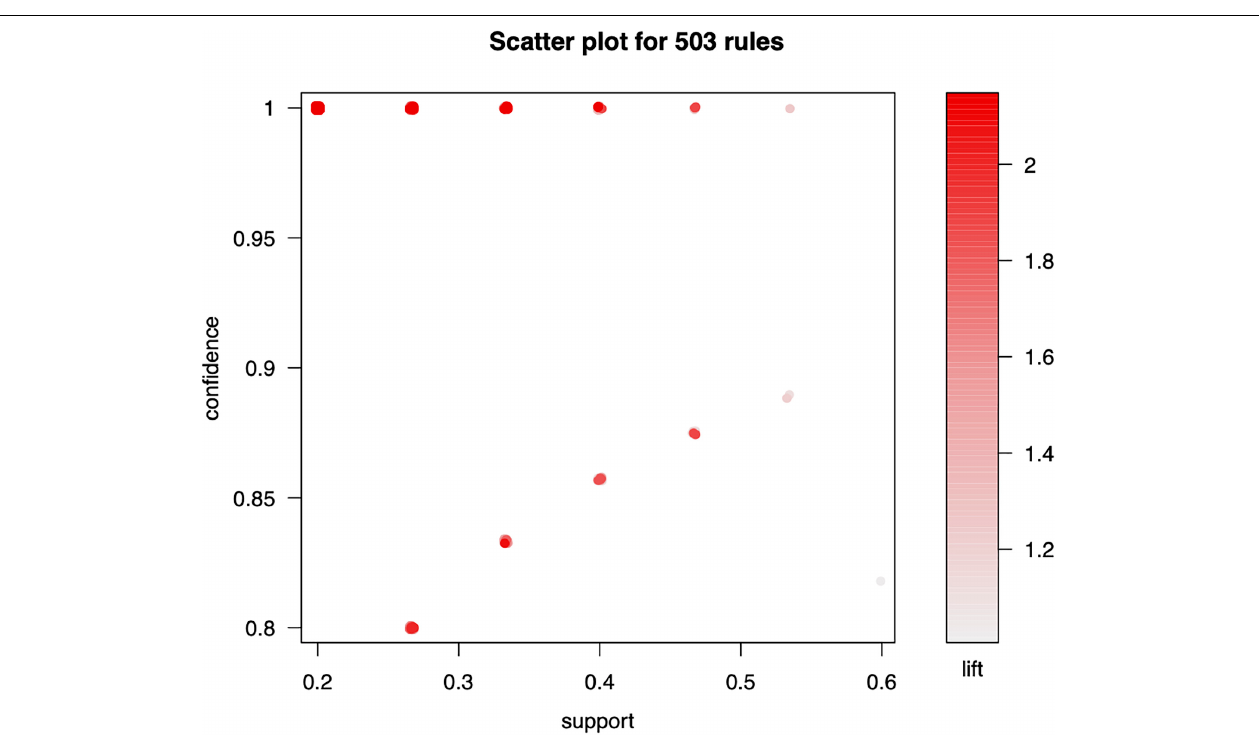
the association rule. The lift value of a rule is the ratio between the observed support and that expected if X and Y are independent. As shown in Figure 2 , rules with high lift